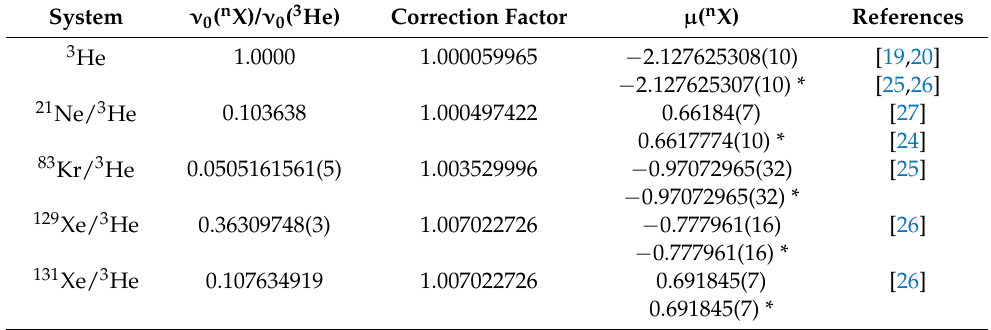
Table 2. NMR parameters for calculating the µ ( n X) nuclear magnetic moments of noble gases.